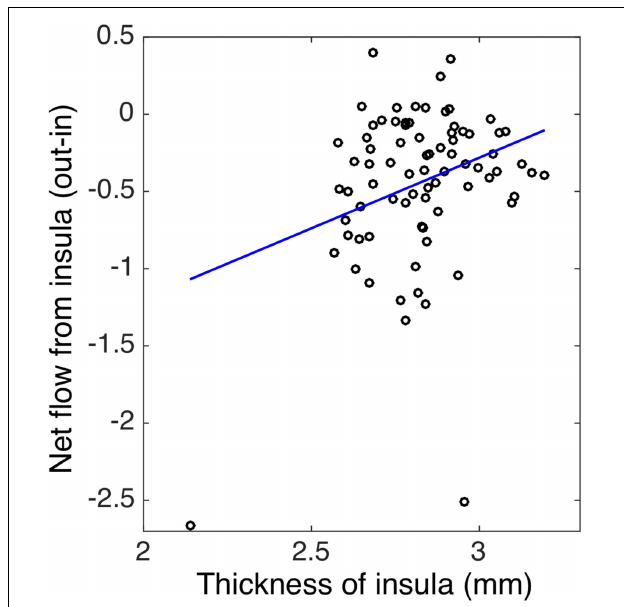
FIGURE 6 | The correlation between the thickness and the net flow (out-in) of insula in both African–Americans (AA) and Caucasian–Americans (CA) ( r = 0.31 and p <